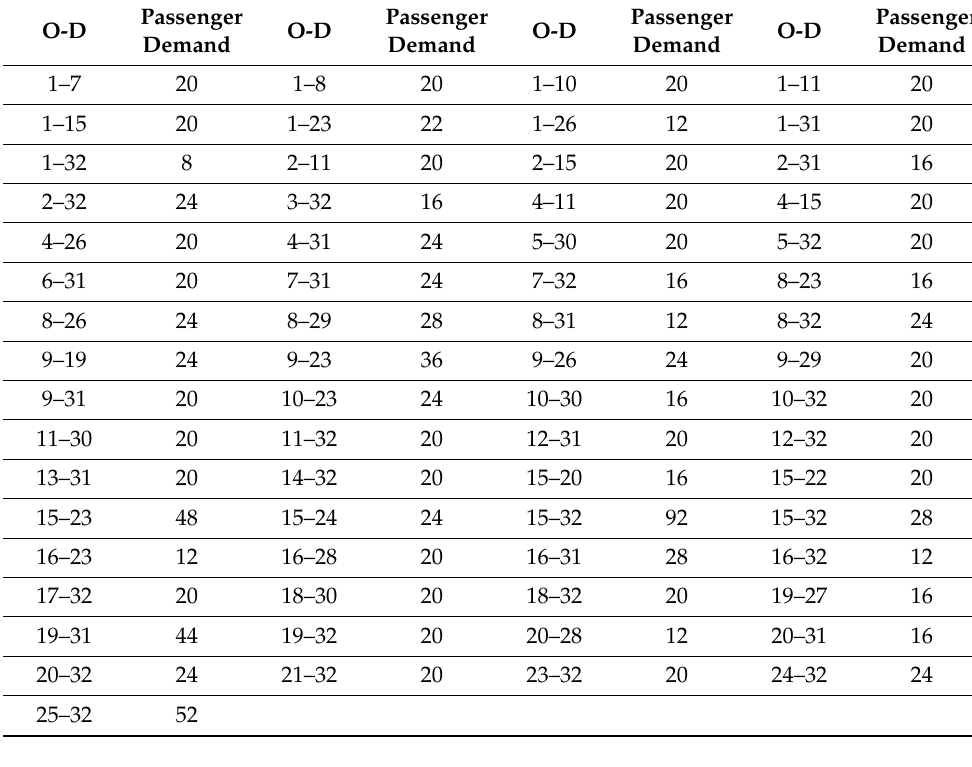
Table 1. OD matrix of Bus Route 202 in the direction of Rongbing → Zhenjiang railway station during the morning peak (7:00 a.m.– 8:00 a.m.).